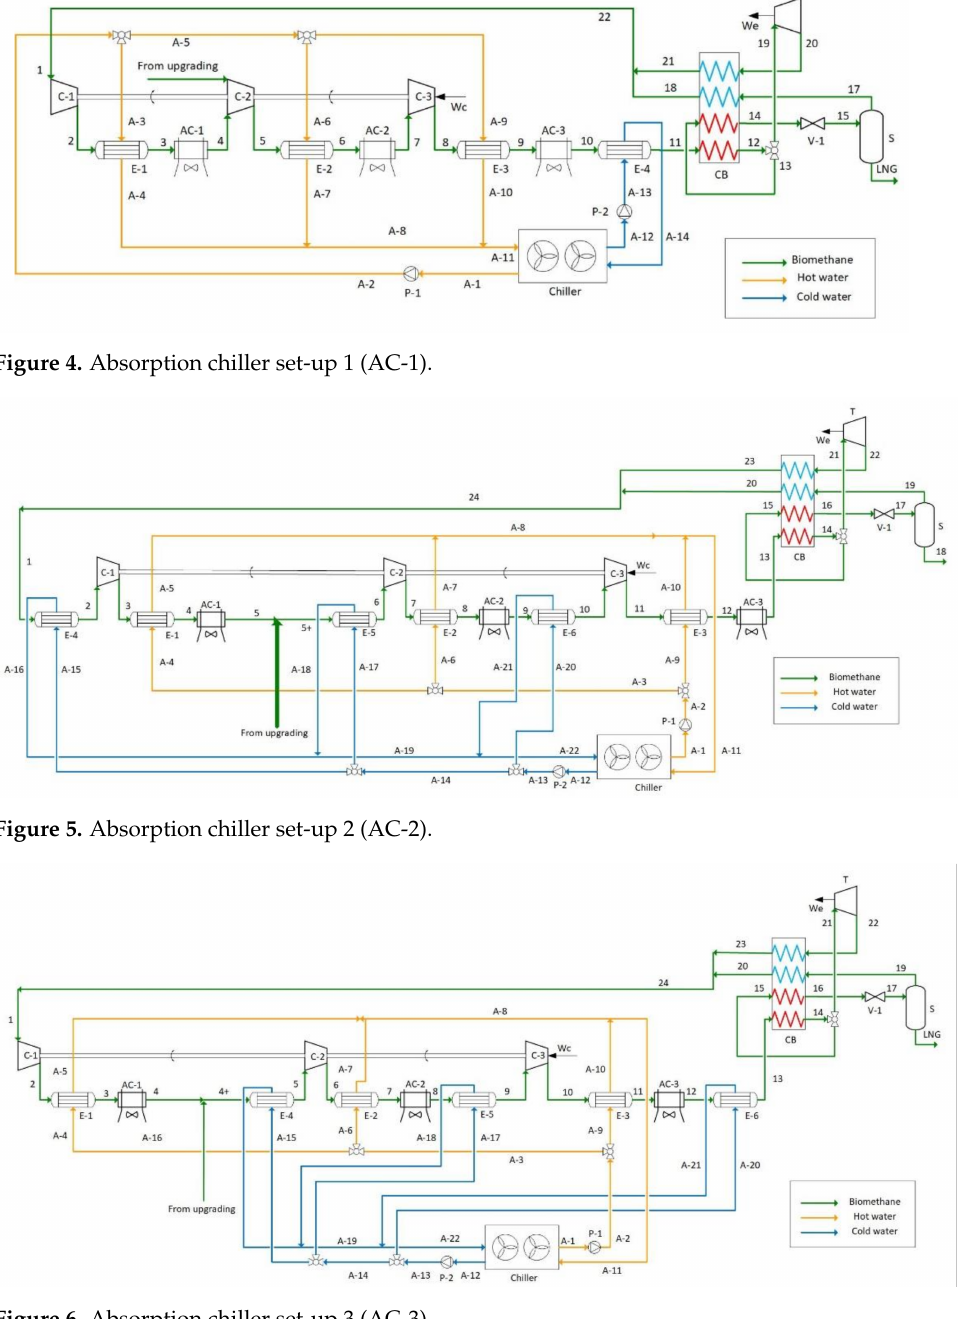
Figure 6. Absorption chiller set-up 3